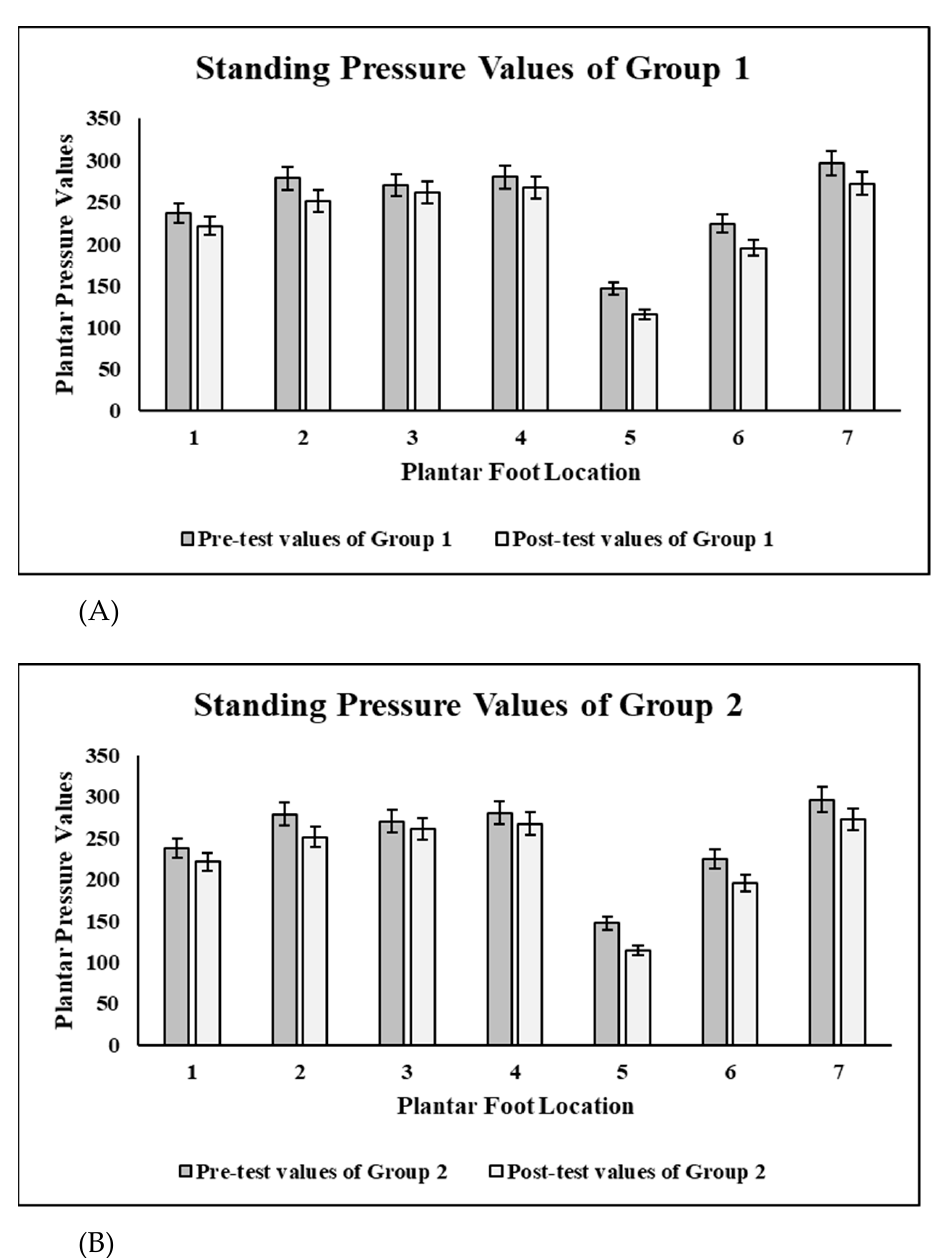
Figure 7. Pressure values taken in standing position in 3D-printing-based group 1 ( A ) and standard-of-care insole group 2 ( B ) at seven different locations in the plantar region, 1: hallux, 2: first metatarsal, 3: third metatarsal, 4: fifth metatarsal, 5: medial mid-foot, 6: lateral mid-foot and 7: heel, for ( A ) experimental group and ( B ) control group.